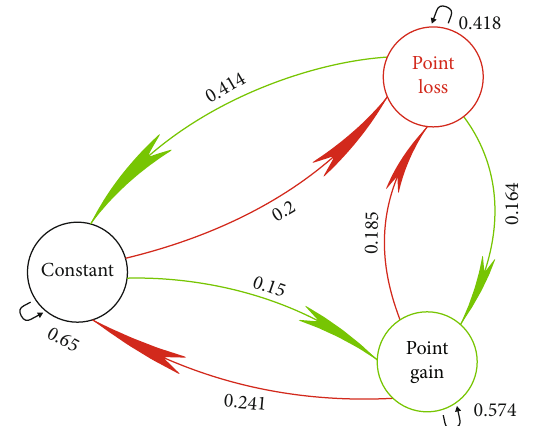
Figure 11: Societe Generale Ghana Ltd. equity transition matrix and diagram.